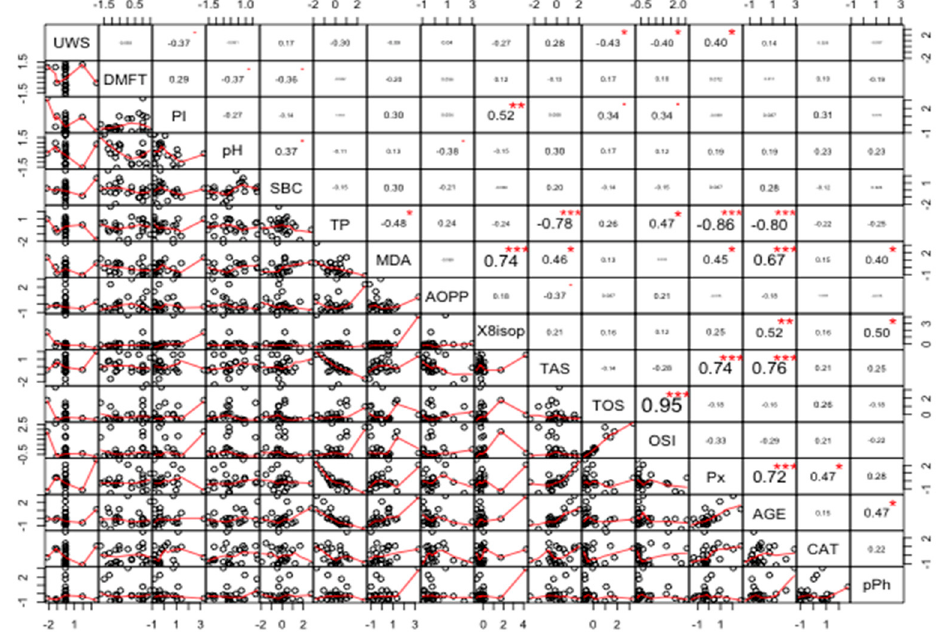
Figure 12. Coe ffi cients of correlation between parameters measured in the saliva of healthy women without the BRCA1 mutation (NZ). NZ, generally healthy patients without the BRCA1 mutation; AOPP, advanced oxidation protein products; TP, total protein; OSI, oxidative stress index; TOS, total oxidant status; TAS, total antioxidant status; CAT, catalase activity; pPh, total phenolic content; Pl.I score, Plaque Index; DMFT, decay, missing, filled teeth; UWS, unstimulated whole saliva; SBC, salivary bu ff er capacity; 8-isop, concentration of 8-isoprostane; MDA, concentration of malondialdehyde; AGE, advanced glycation end-products; SBC, bu ff er capacity of saliva; Px, activity of salivary peroxidase. * p < 0.05; ** p < 0.01; *** p <